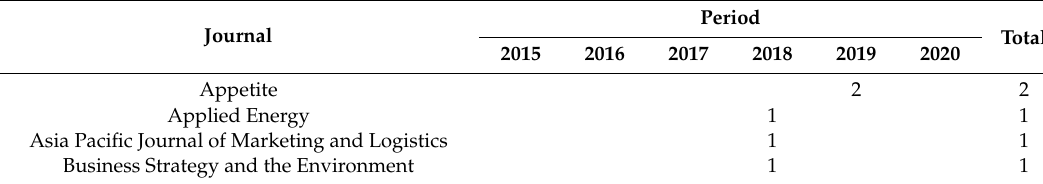
Table A1. Summary of literature search results and number of